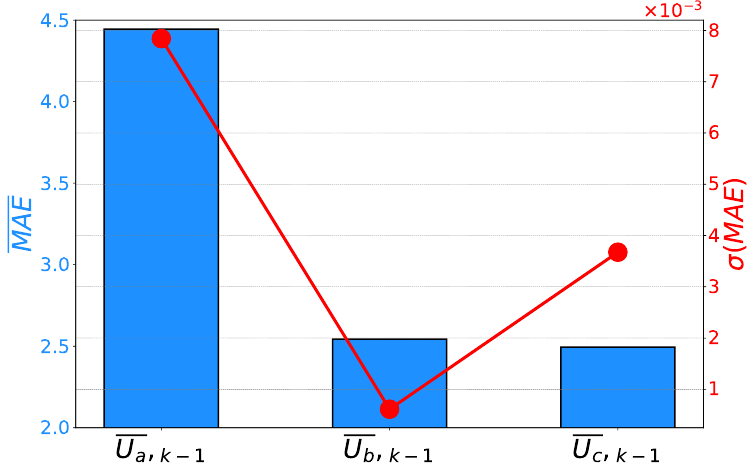
Figure 9. Mean MAE scores and their standard deviations achieved on the prediction of phase voltages.